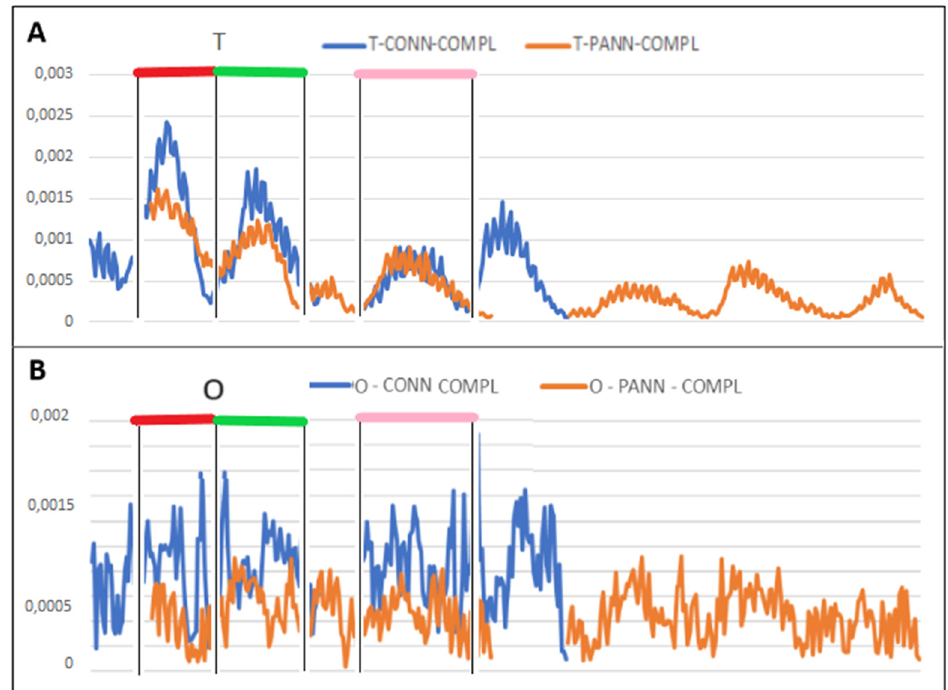
Figure 7. Comparison of hydrophobicity profiles: ( A )—profile T, ( B )—profile O analogical in pan- nexin (red) and connexin (blue) as observed in the complex and sections identified as analogous in T profiles of complexes. Similar fragments are distinguished by colors according to the presentation in Figure 8 and Table 2.